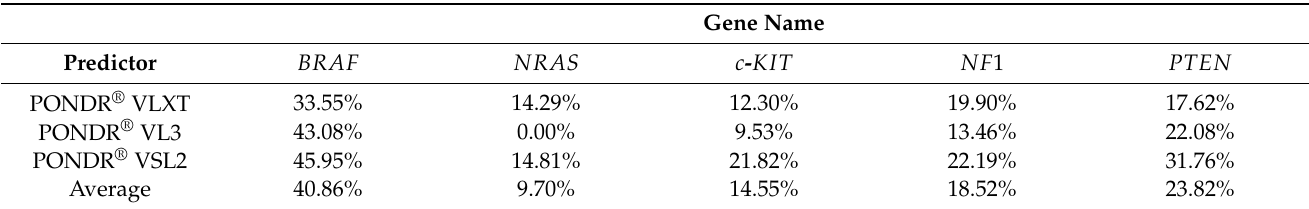
Table 2. Predictor of Natural Disordered Protein Region (PONDR) analysis quantifying the percentage of predicated intrinsic disorder of human proteins associated with conjunctival melanoma.